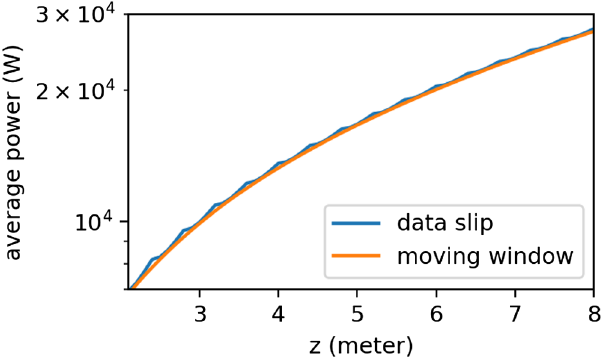
FIG. 9. Comparison of the convergence between three different integration orderings. P 0 is the reference power curve, Δ P is the difference between the power curve simulated with a large step size ( Δ z ¼ 20 λ u ) and the reference curve. Same parameters are used as Fig. 6. The large deviation at the initial stage is due to